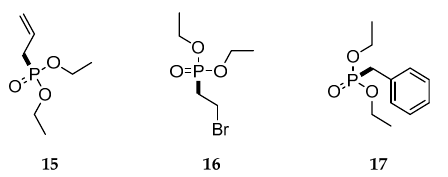
Figure 10. Flame retardant compounds 15 , 16 and 17 .